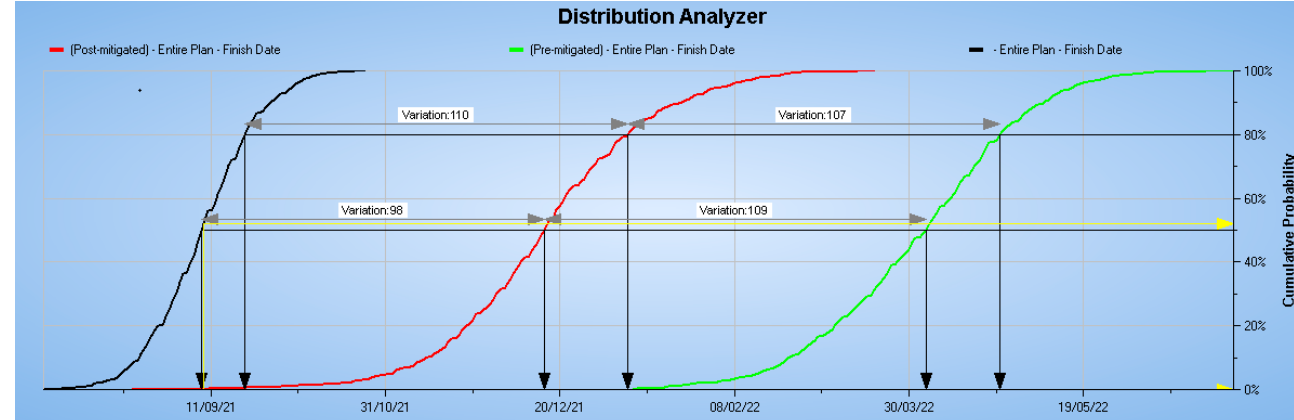
Figure 12. Variations in project duration under the influence of risks and after the implementation of compensatory measures.